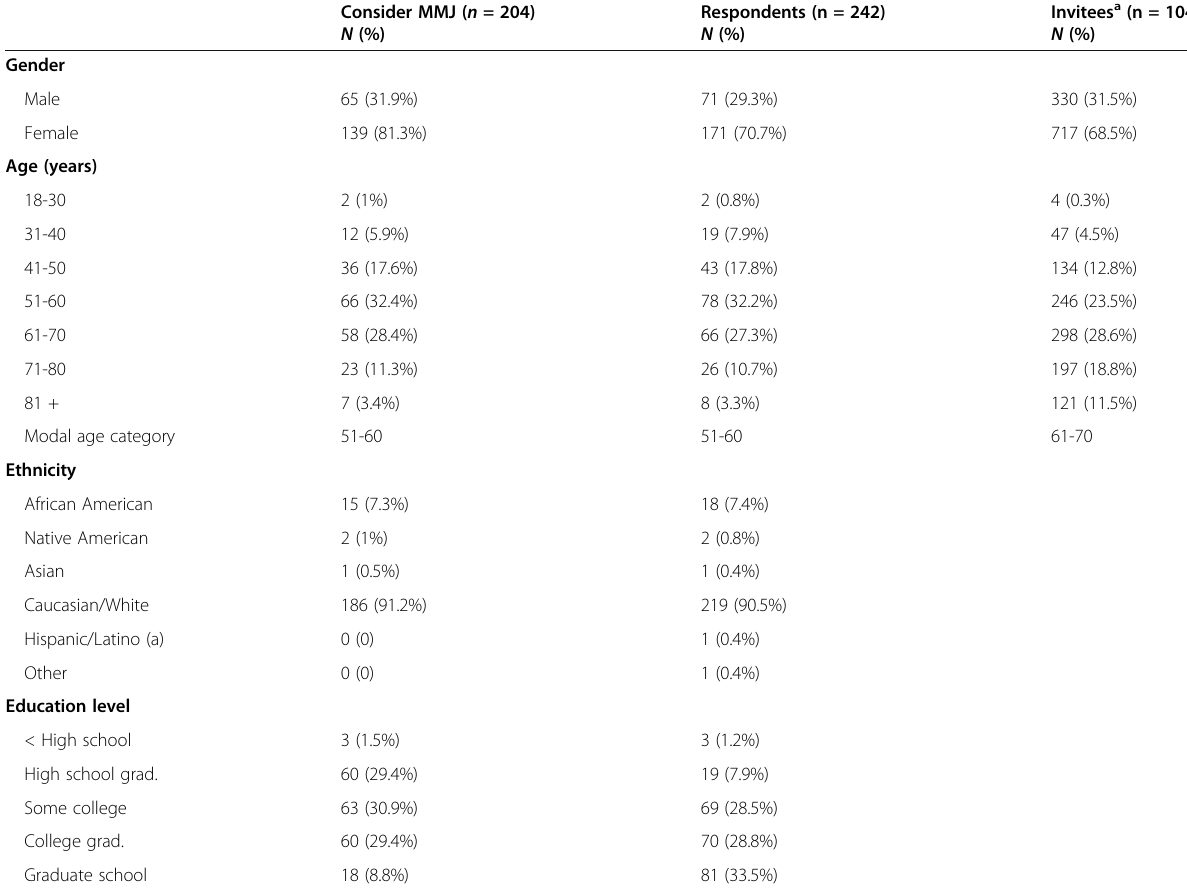
Table 2 Responses to questions 1-4: Demographic characteristics of all chronic pain patients sent invitations to complete the survey. Columns indicate those considering medical marijuana, all respondents and all invitees Consider MMJ ( n = 204) N (%)